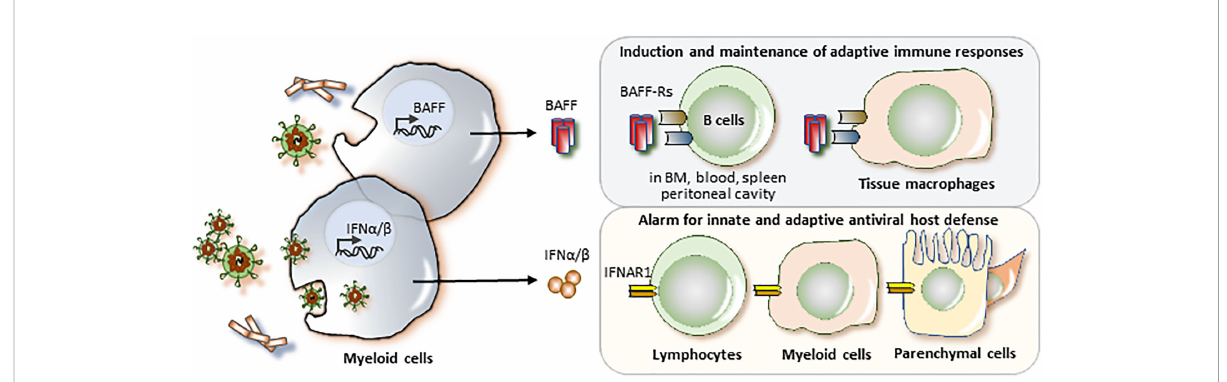
FIGURE 1 BAFF and the IFNAR1 in host defense. All classes of pathogens release pathogen-associated molecular patterns (PAMP) that can activate pattern recognition receptors in myeloid cells to upregulate the expression and release of B cell activating factor (BAFF) and/or interferon-alpha and -beta (IFN a / b ). Viruses are particularly potent in inducing IFN a / b as their viral nucleic acid activate speci fi c nucleic acid sensors in intracellullar compartments such as phagolysosomes inside the cytosol. BAFF mediates its biological effects via the BAFF receptor (BAFF-R) on T1 B cells in the bone marrow, blood, and spleen, on B1B cells in the peritoneal cavity, and on follicular B cells and marginal zone B cells in the spleen. BAFF has a speci fi c role in the induction and maintenance of adaptive immune responses. In addition, tissue macrophages express BAFF-R and IFNAR1 and BAFF and IFNAR1 ligation both induce a M1 proin fl ammatory macrophage phenotype, an innate mechanism of host defense. In addition, nearly all cells of the body express the IFNAR1. Activation of the IFNAR1 activates immune and tissue cells to induce several hundred genes important in antiviral host